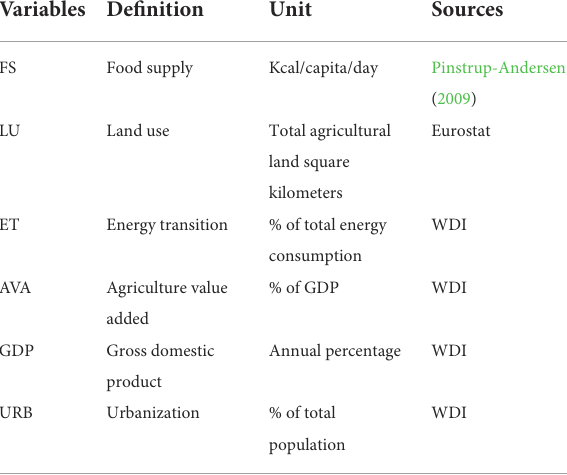
TABLE 1 Variables